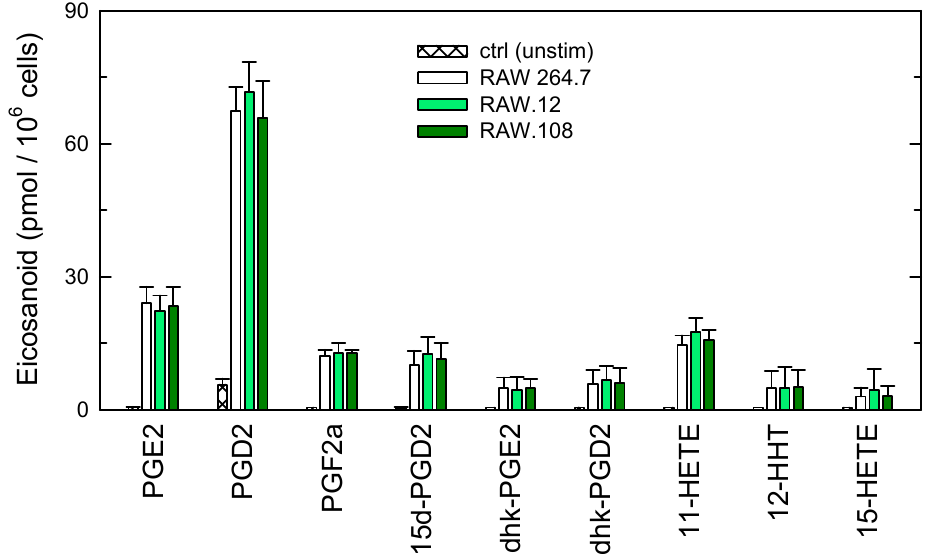
Figure 4. Eicosanoid production by RAW 264.7 cells and plasmalogen-deficient variants: RAW 264.7 cells (open bars), RAW.12 cells (light green bars), and RAW.108 cells (dark green bars) were stimulated with 150 µ g / mL zymosan for 8 h. Afterward, extracellular media was removed and analyzed for eicosanoid levels by LC / MS. Eicosanoids produced by untreated RAW 264.7 cells (crosshatched bars) are shown for comparison. Results are shown as means ± S.E.M. (n = 3). PGE2, prostaglandin E 2